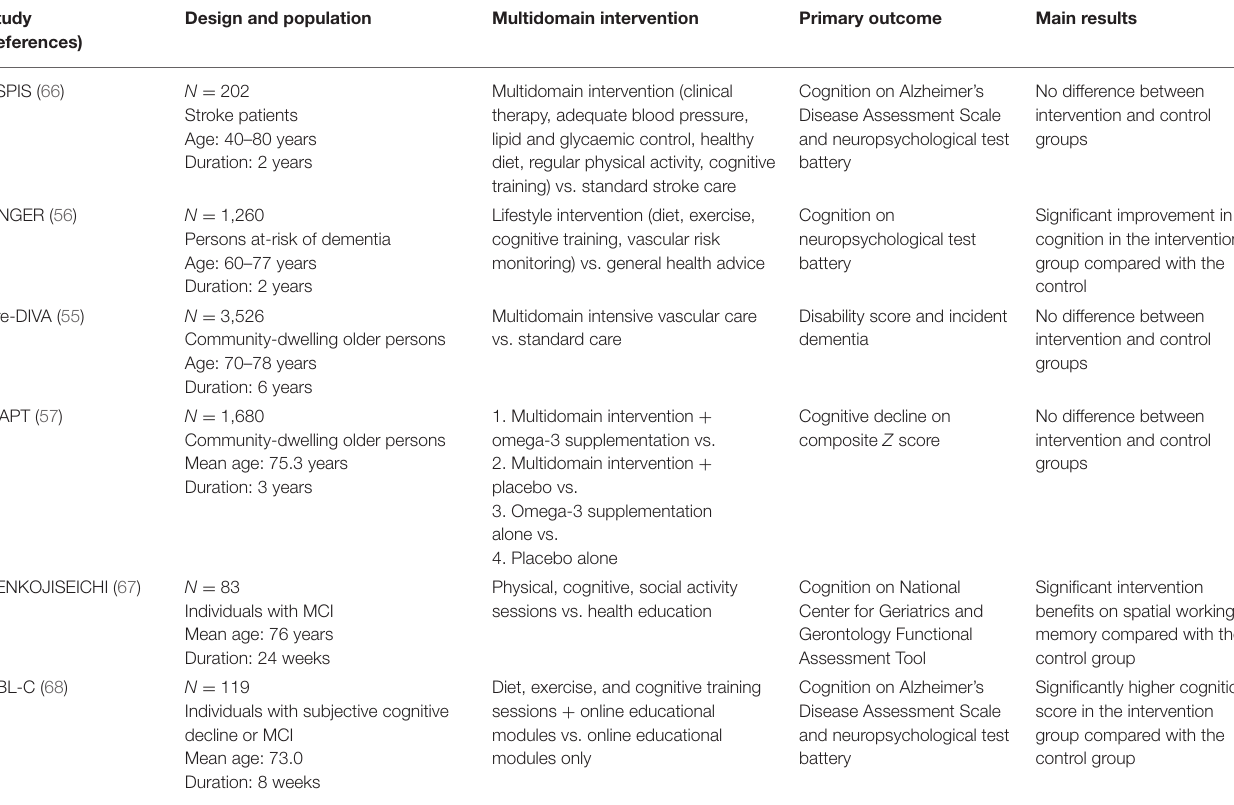
TABLE 1 | Summary of non-pharmacological multidomain (at least three components) trials with cognitive decline related primary